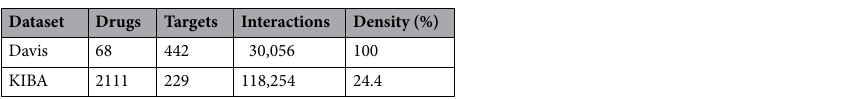
Table 1. The statistics of two